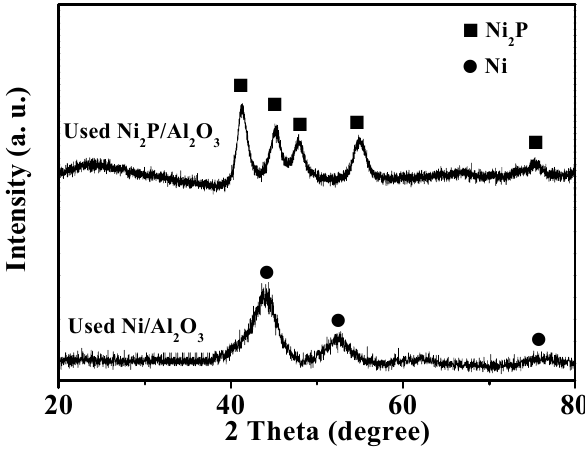
Figure 4. XRD patterns of the used Ni/Al 2 O 3 and Ni 2 P/Al 2 O 3 catalyst.